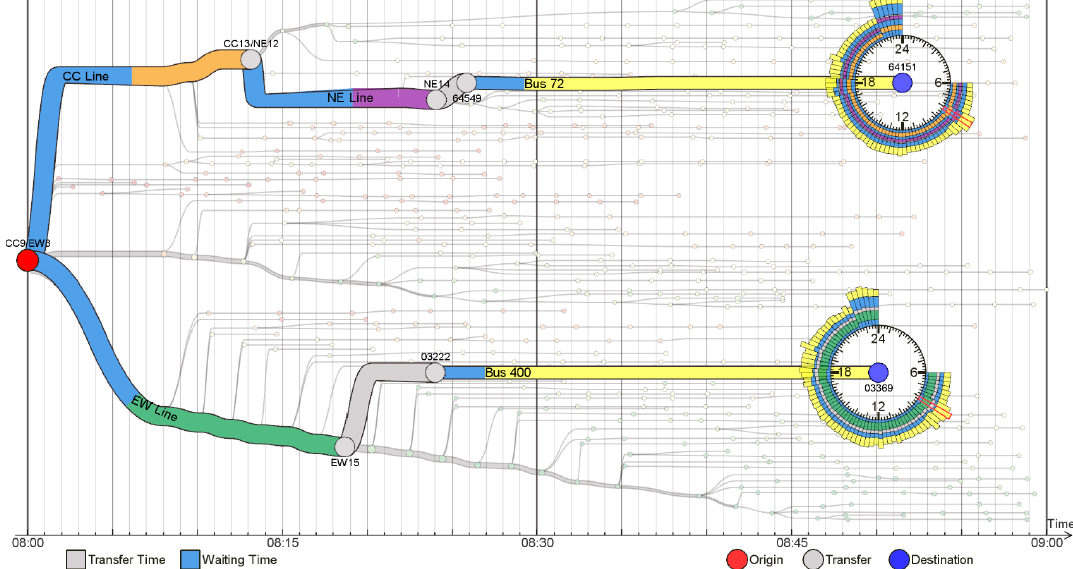
Figure 15. The OD-pair journey view uses the isotime visualization technique to analyze different route options for the same OD-pair [61] (extracted from